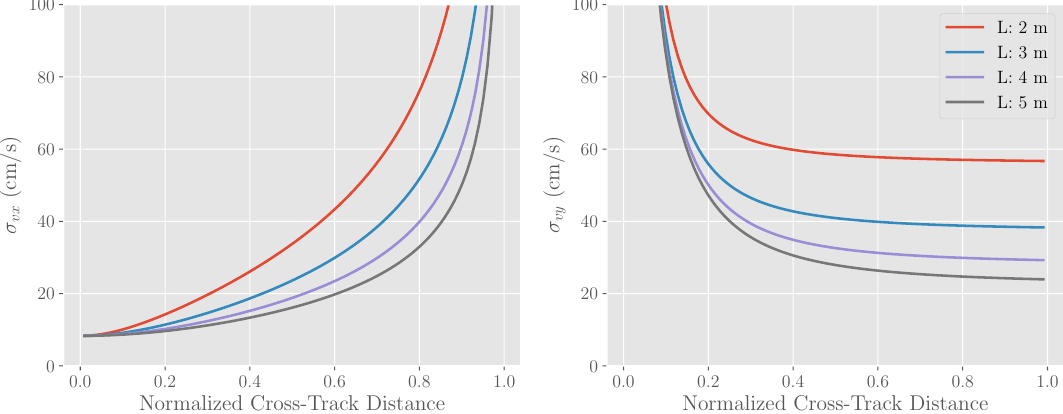
Figure 11. Expected surface velocity standard deviation as a function of normalized cross-track distance from nadir for the along-track ( left ) and cross-track ( right ) surface velocity components for a peak output power of 100W and varying antenna length, L